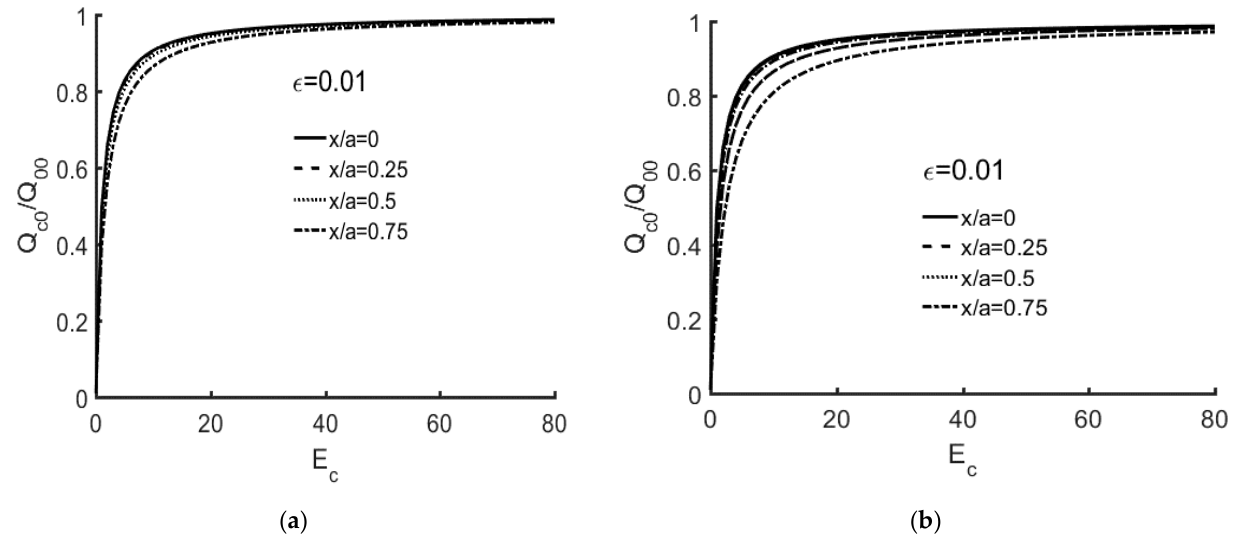
ε Figure 2. ( a ) Q c 0 / Q 00 versus Ec with x/a = 0, 0.25, 0.5, 0.75 for = 0.01. The orthotropic material listed in Table 1; ( b ) Figure 2. ( a ) Q c 0 / Q 00 versus Ec with x/a = 0, 0.25, 0.5, 0.75 for ε = 0.01. The orthotropic material listed in Table 1; ( b ) Q c 0 / Q 00 ε Q c 0 / Q 00 versus Ec with x/a = 0, 0.25, 0.5, 0.75 for = 0.01. The isotropic material listed in Table 2. versus Ec with x/a = 0, 0.25, 0.5, 0.75 for ε = 0.01. The isotropic material listed in Table 2.